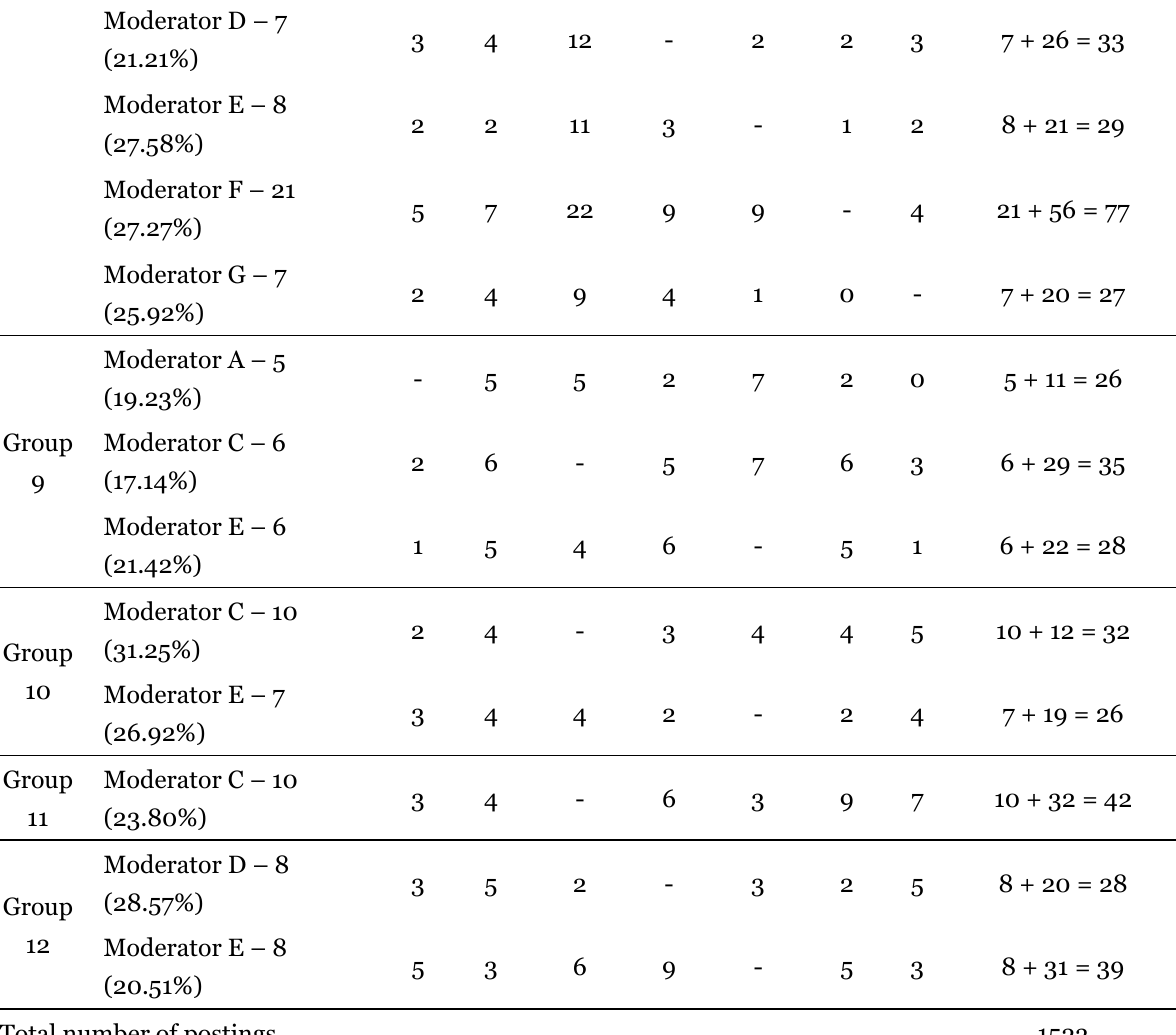
derived from Figure 3, the overall pattern of e-moderating is not similar in different thread patterns. Generally, PMs predominantly give students supports focusing on ‘Information exchange’ (35.79%), followed by support invoking ‘Knowledge construction’ (28.11%) and ‘Socialization’ (21.15%) which were enacted 247, 194, and 146 times,